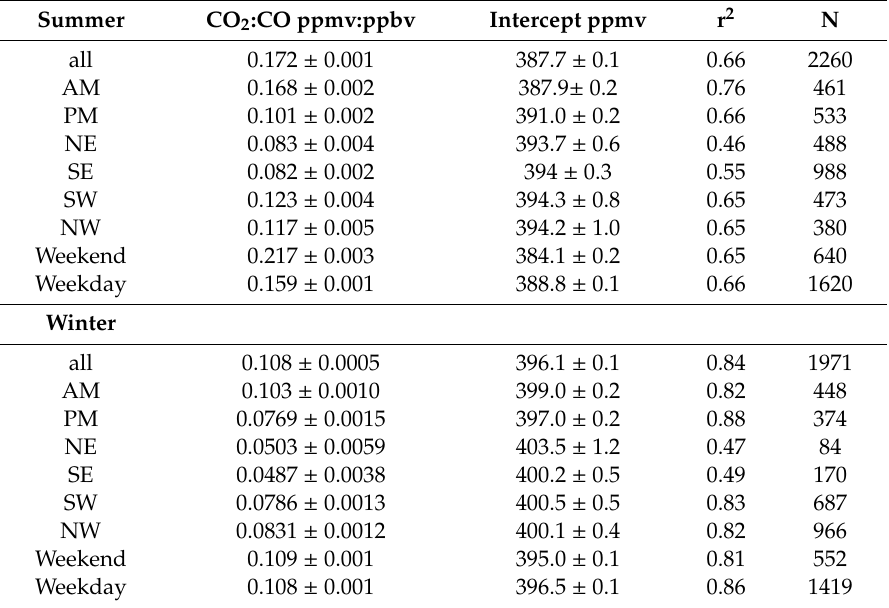
Summer: October 2016 to March 2017; Winter: May 2017 to September 2017. Data is filtered for wind speeds > 0.5 m s − 1 . AM Summer: 5:00 to 9:00; Winter 6:00 to 10:00 am PM Summer 15:00 to 19:00; Winter 16:00 to